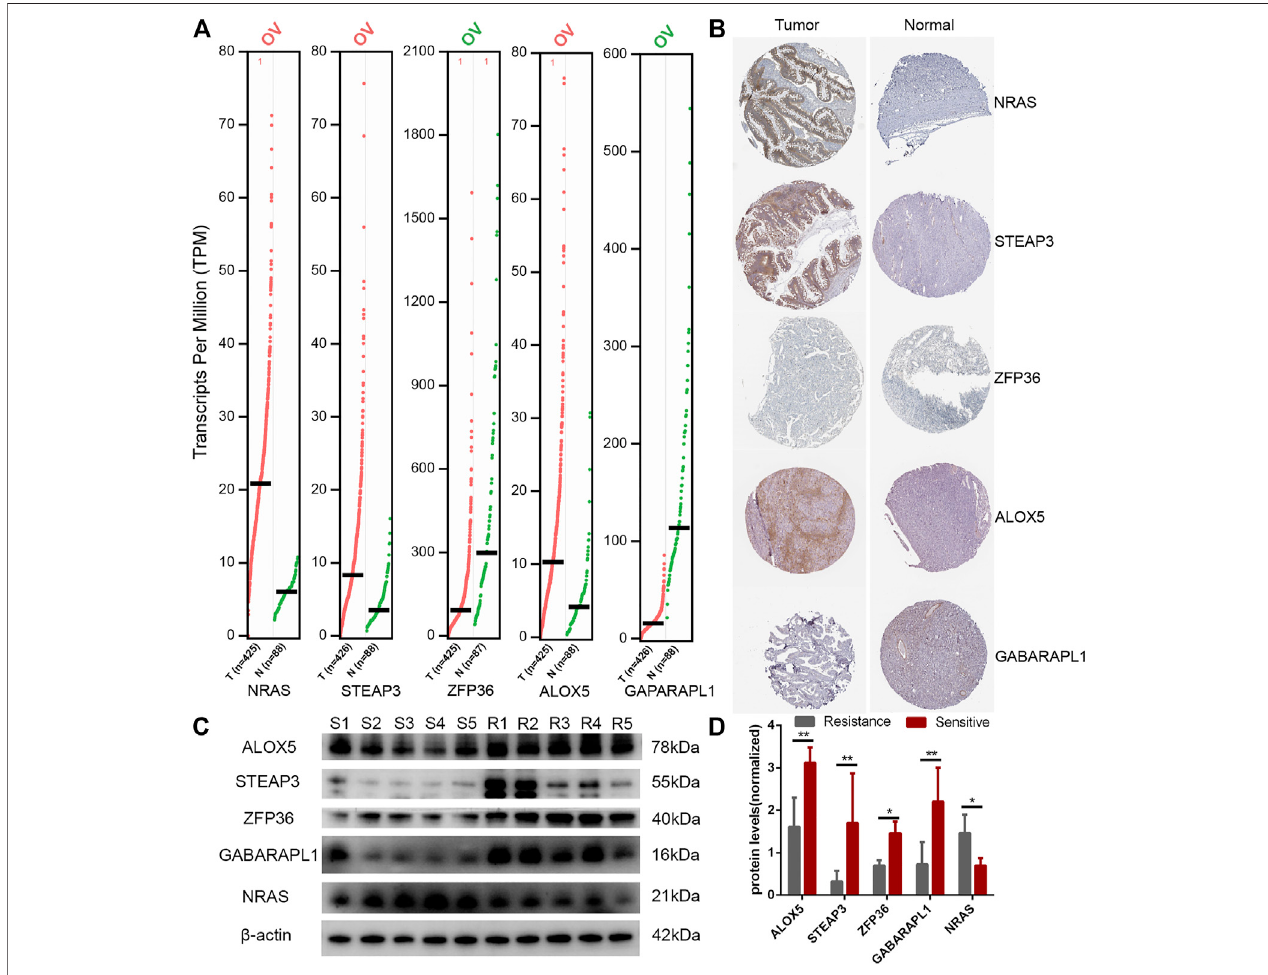
FIGURE 10 | Expression of FRGs in the E-FRG model. (A) GEPIA database showing the expression of TOP5 different genes in OC tissues compared with normal tissues. (B) HPA database showing the expression of TOP5 different genes in OC tissues compared with normal tissues. (C) Protein expression of TOP5 genes in the E-FRG model (ALOX5, STEAP3, ZFP36, GABARAPL1, and NRAS) and β -actin in platinum-resistant tissues (R1-R5) and platinum-sensitive tissues (S1-S5). (D) Error bars represent the standard deviation (s.d.) of quintuplicate measurements. * p < 0.05 and ** p <